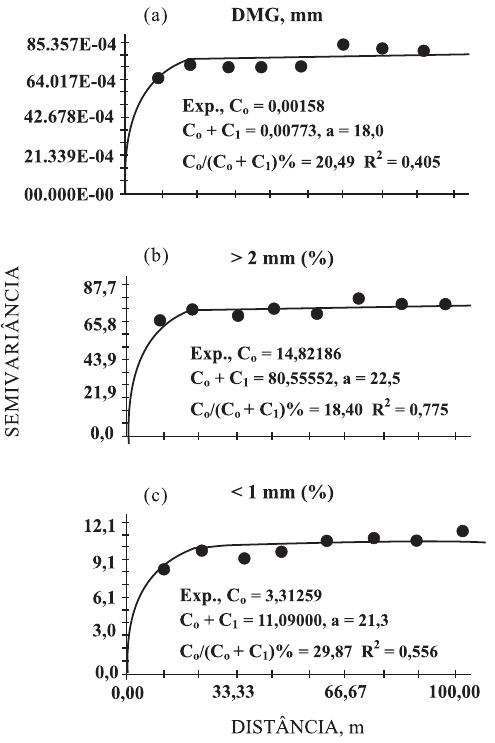
Figura 1. Semivariogramas dos atributos estudados: (a) diâmetro médio geométrico (DMG) (b) agregados da classe > 2,0 mm; (c) agregados da classe < 1,0 mm; Exp.: exponencial; C pepita; C : patamar; a: alcance; R 2 : coeficiente 1